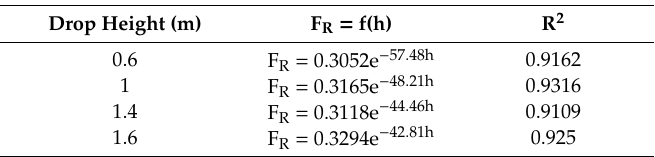
Table 6. Correlation between the impact force F R and the height h for the drop hammer weight of 100 kg without the support